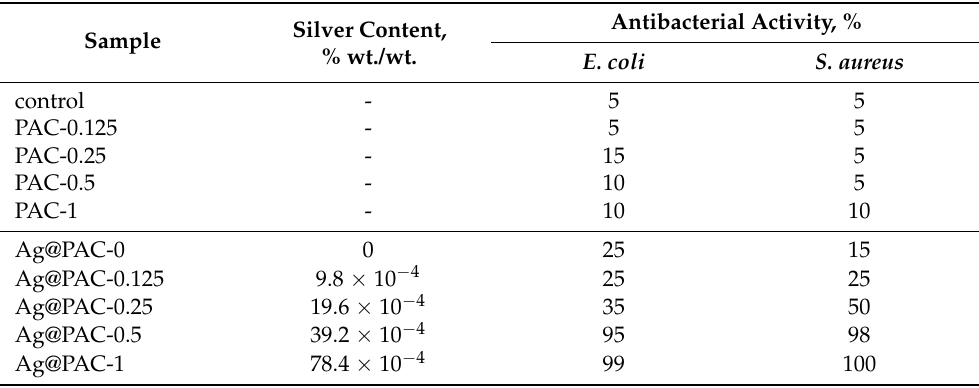
Table 4. Silver content (% wt./wt. with respect to the total solid content) and antibacterial efficiency of the PAC and Ag@PAC series against Gram-negative ( E. coli ) and Gram-positive ( S. aureus ) samples.